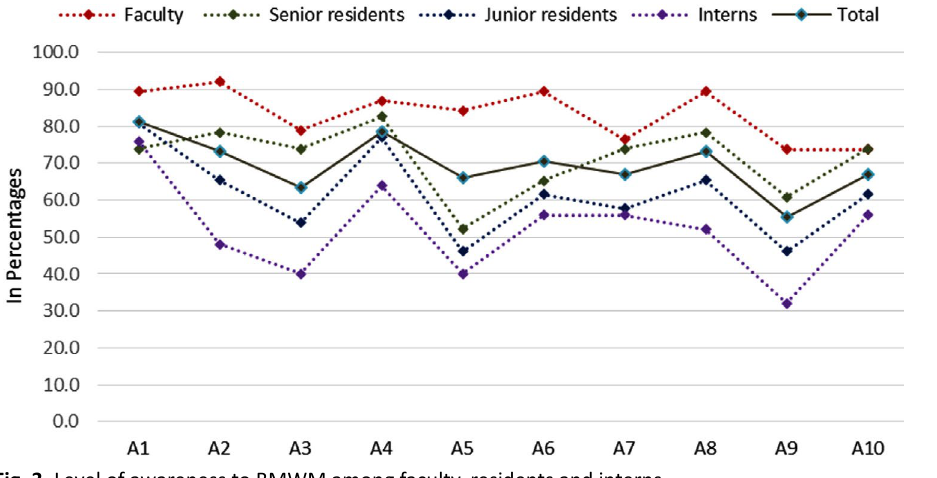
Fig. 3. Level of awareness to BMWM among faculty, residents and interns.